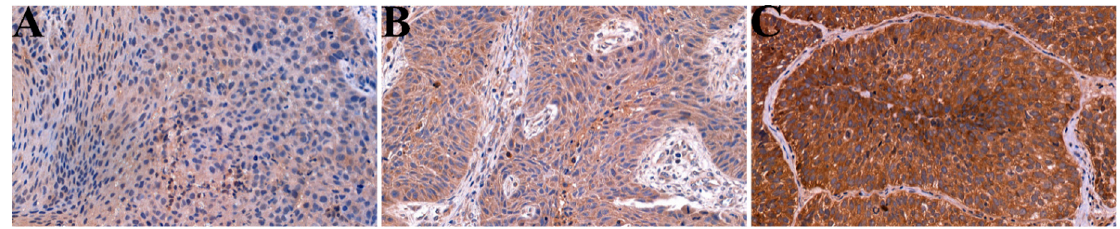
Figure 1. Examples of immunostaining in head and neck squamous cell carcinomas (HNSCC). ( A ) Low GnRH-R expression; ( B ) moderate GnRH-R expression; ( C ) high GnRH-R expression. (Magnification: × 40).